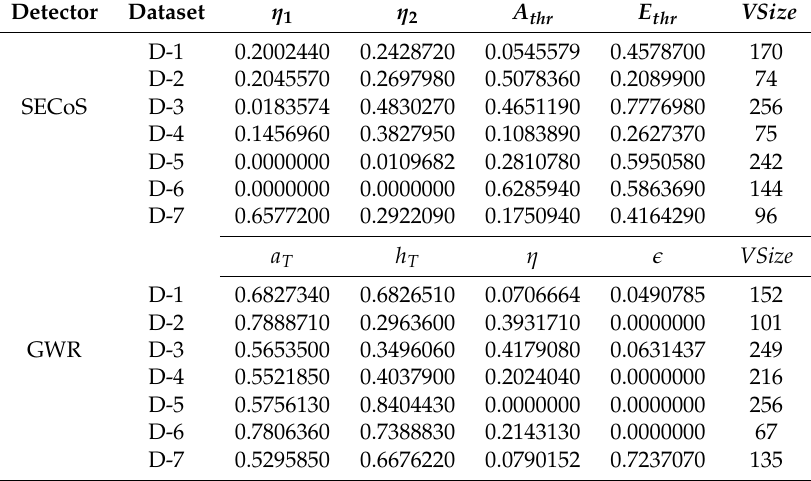
Table 6. Set of sample evolved detectors generated by the proposed global optimization framework on all the